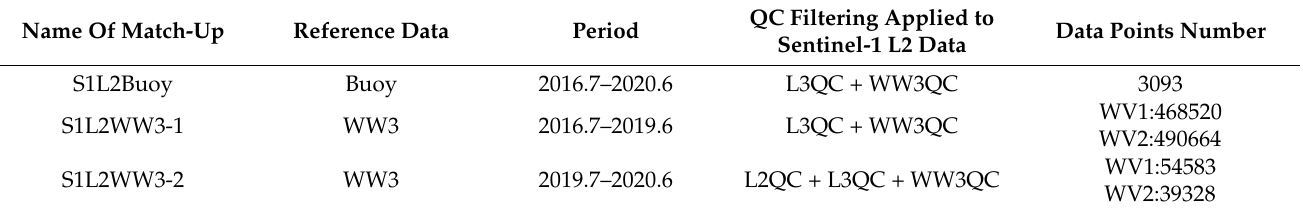
Table 1. Three swell height match-up datasets of Sentinel-1 WV L2 data collocated against reference. QC Filtering Applied to Name Of Match-Up Reference Data Period Data Points Sentinel-1 L2 Data